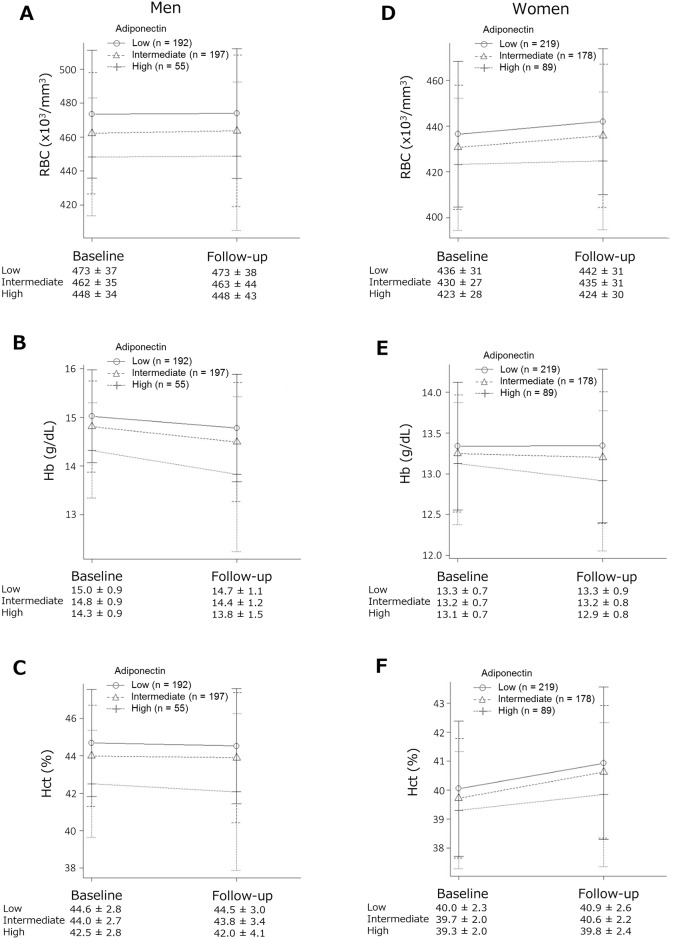
Differences in the levels of the erythroid-related parameters stratified according to adiponectin levels at baseline.The non-anemia groups were subdivided into three subgroups (low, intermediate, and high) according to serum adiponectin levels at baseline. In men in the high adiponectin subgroup, hemoglobin (Hb) [Fig 2.B] and hematocrit (Hct) [Fig 2.C] levels were lower at follow-up than at baseline, whereas red blood cell (RBC) counts [Fig 2.A] were unchanged. In women in the high adiponectin subgroup, Hb levels [Fig 2.E] were lower, and RBC counts [Fig 2.D] and Hct [Fig 2.F] were higher at follow-up than at baseline.